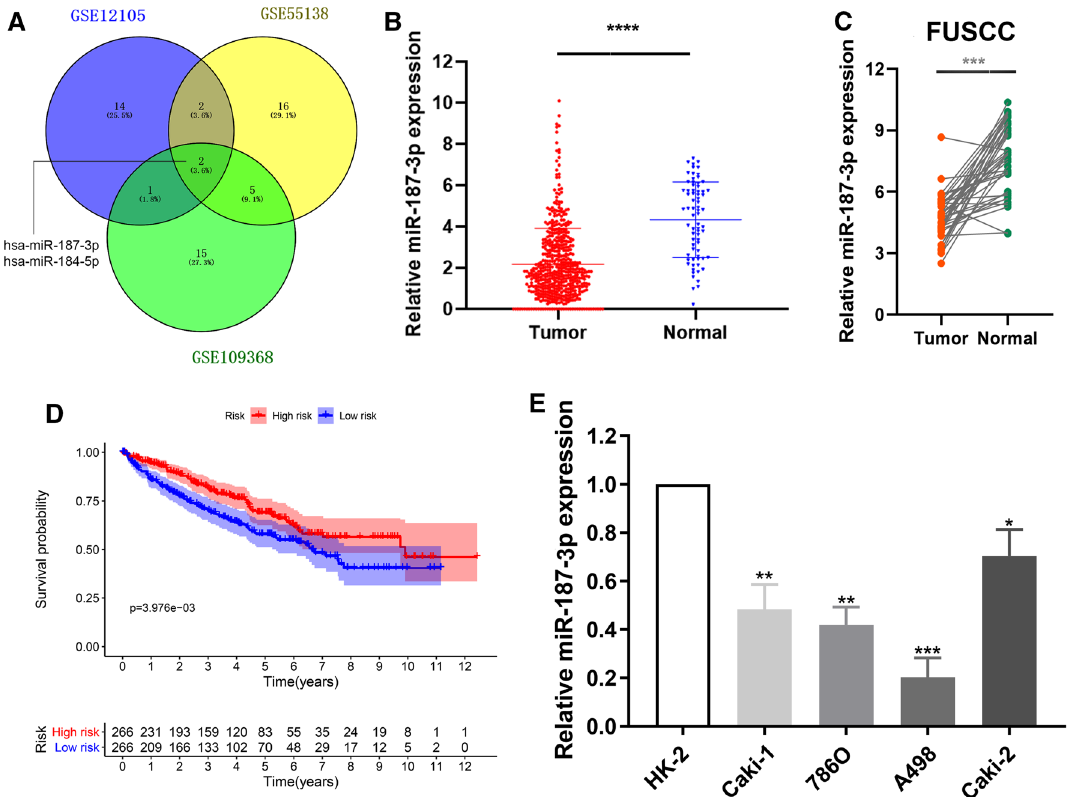
Fig. 1 Screening and identification of miR-187-3p for ccRCC from multiply datasets. A The overlap among the three datasets in Venn dia- gram. B Relative miR-187-3p expression level in ccRCC and normal tissues base on TCGA cohort. C Relative miR-187-3p expression level in ccRCC and normal tissues based on FUSCC cohorts. D Survival plots of miR-187-3p expression for ccRCC patients. E The relative miRNA expressions of miR-187-3p in four ccRCC cell lines and a normal cell line HK-2. * P < 0.05; ** P < 0.01; *** P < 0.001; **** P <